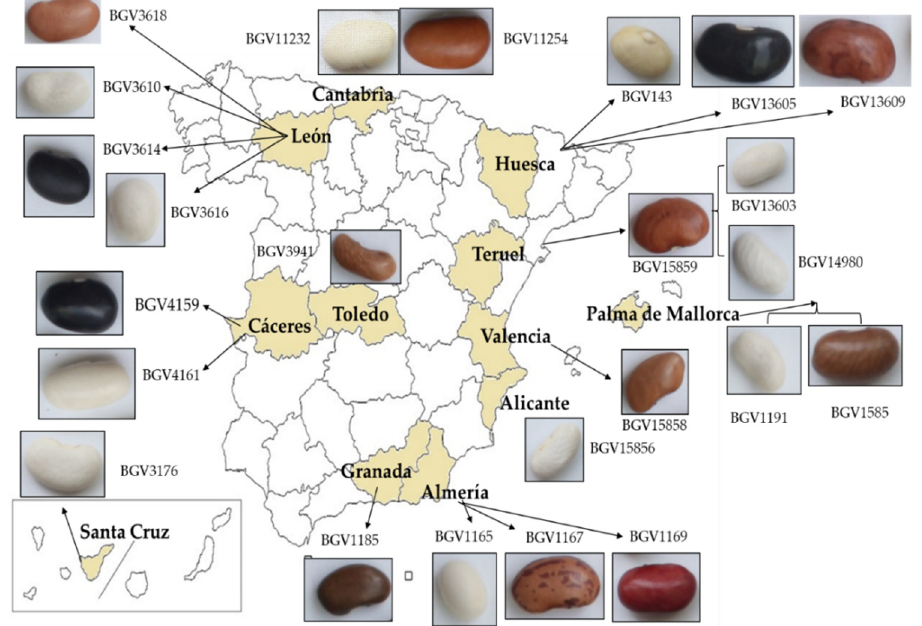
Figure 1. Geographic origin of the 24 Phaseolus vulgaris cultivars.